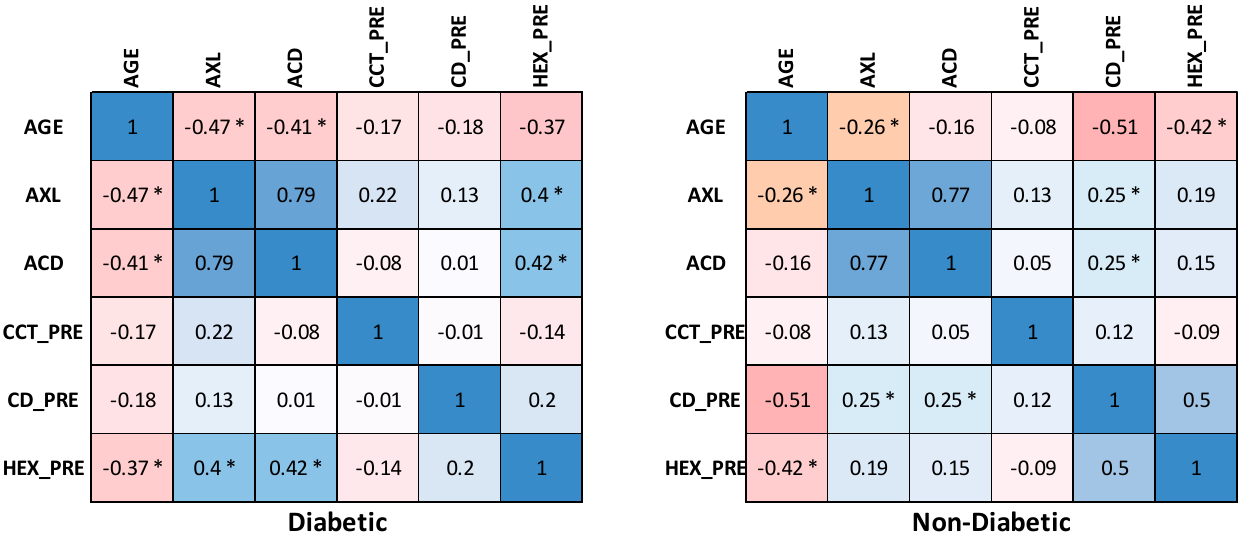
Figure 4. Effective phaco time (EPT) in diabetic versus non-diabetic group.